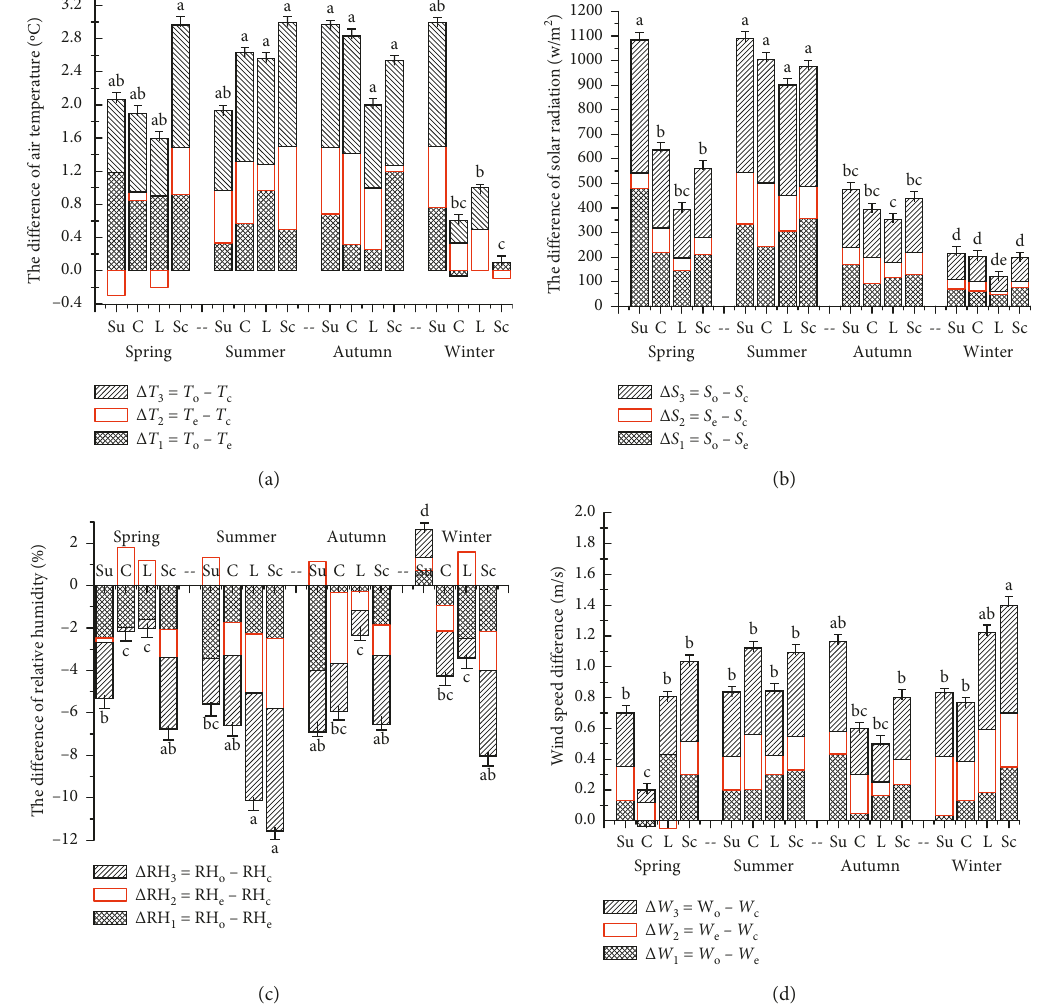
Figure 6: The seasonal micrometeorology parameters difference of Linpan with tree distribution